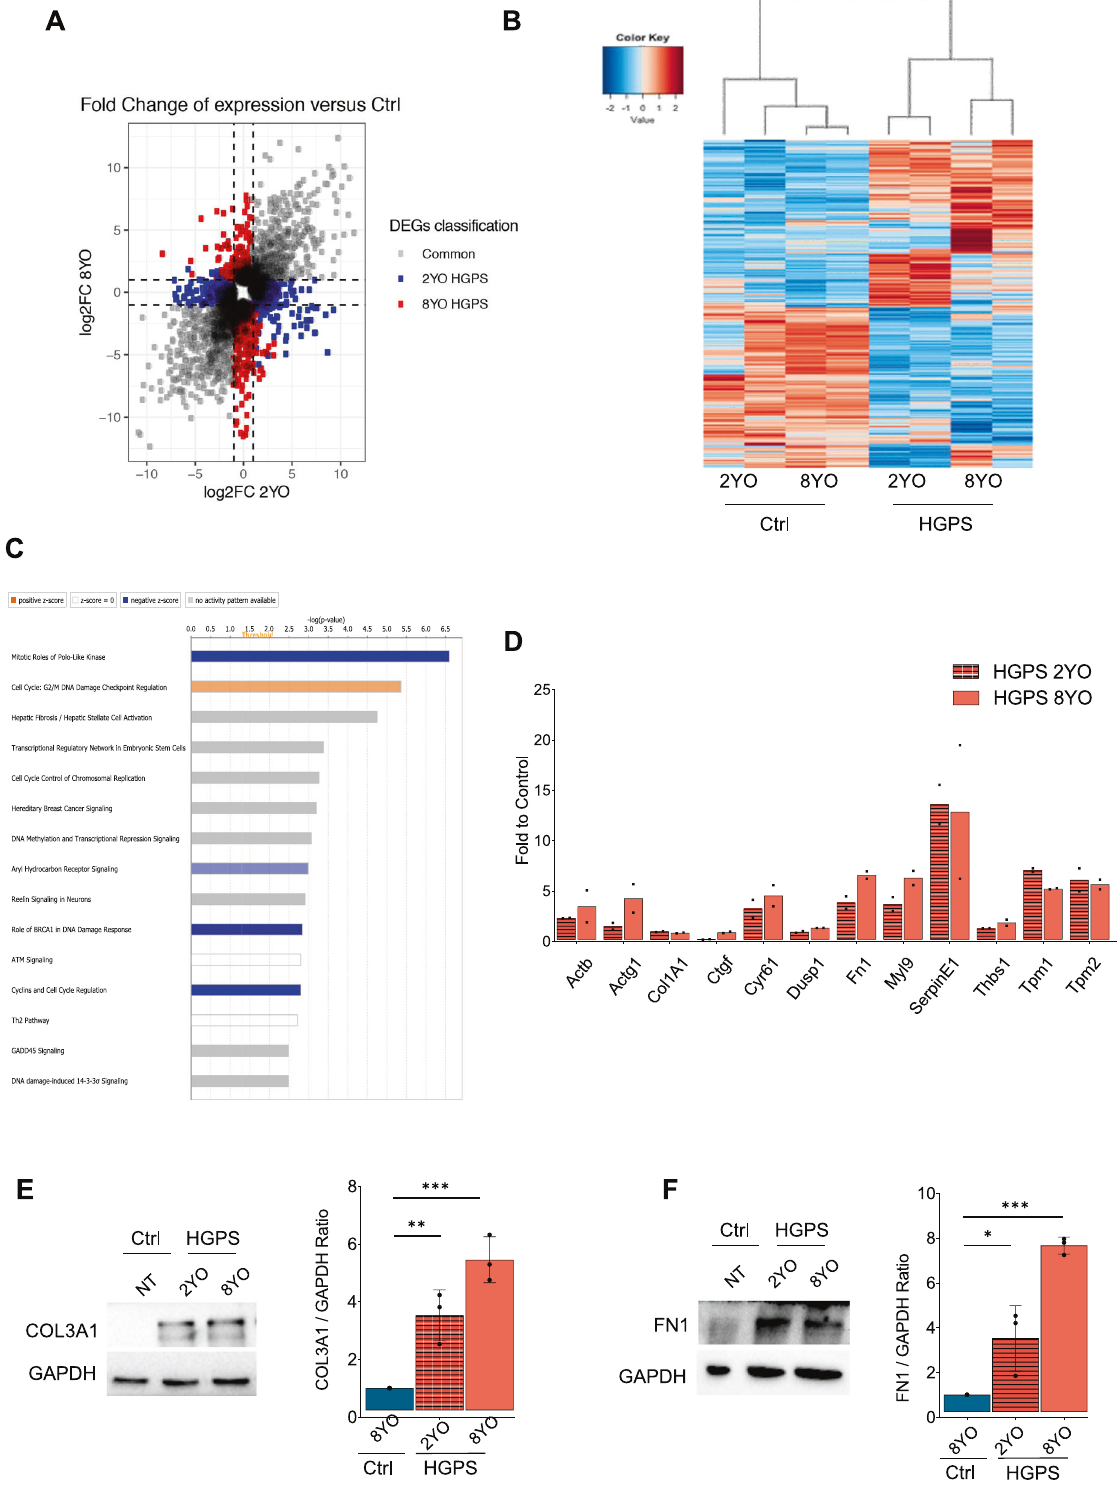
and 53BP1 (Fig. 3C) foci within HGPS cells. As γ -H2AX is a typical event stimulated by DNA damage response (DDR), we used alkaline Comet assay to monitor the DNA damage repair ability at the single- cell level. Indeed, TM5441 treatment led to a signi fi cant reduction of DNA lesions in HGPS fi broblasts at levels similar to the one of control cells (Fig.